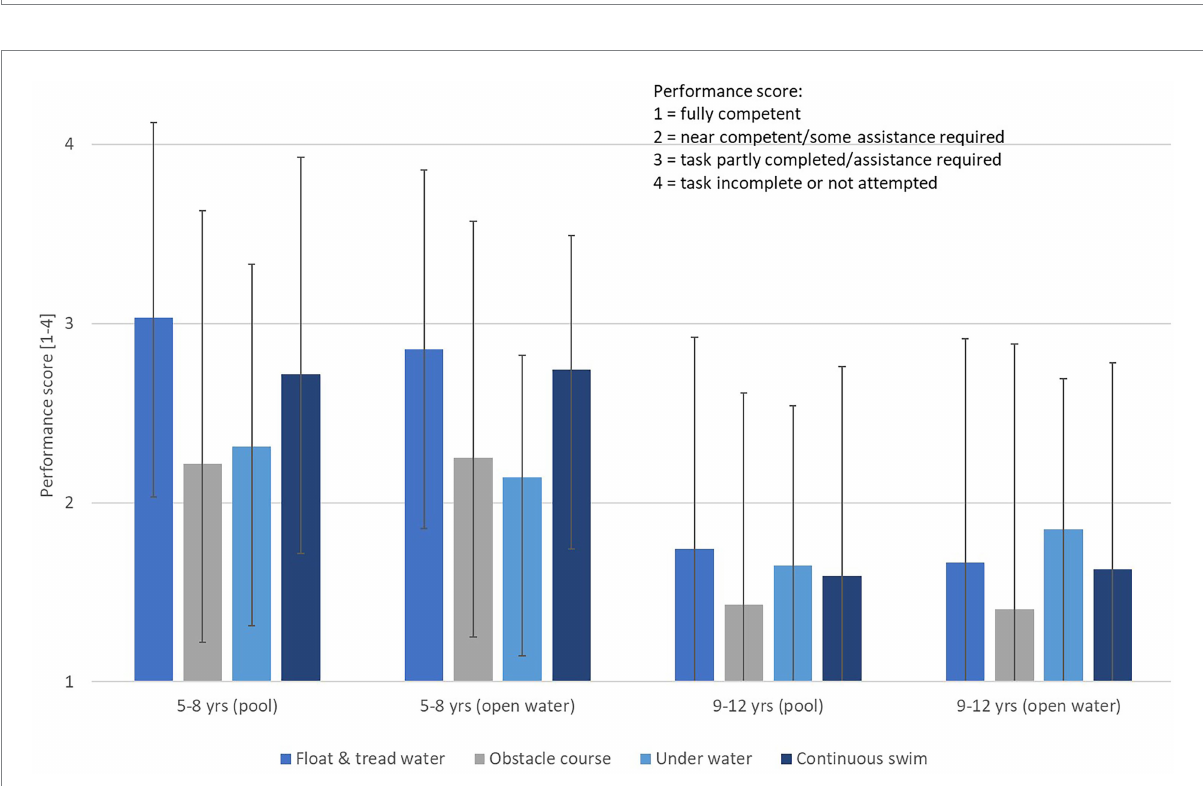
FIGURE 4 Comparison of water safety competency when children of different ages were assessed in a pool or in open